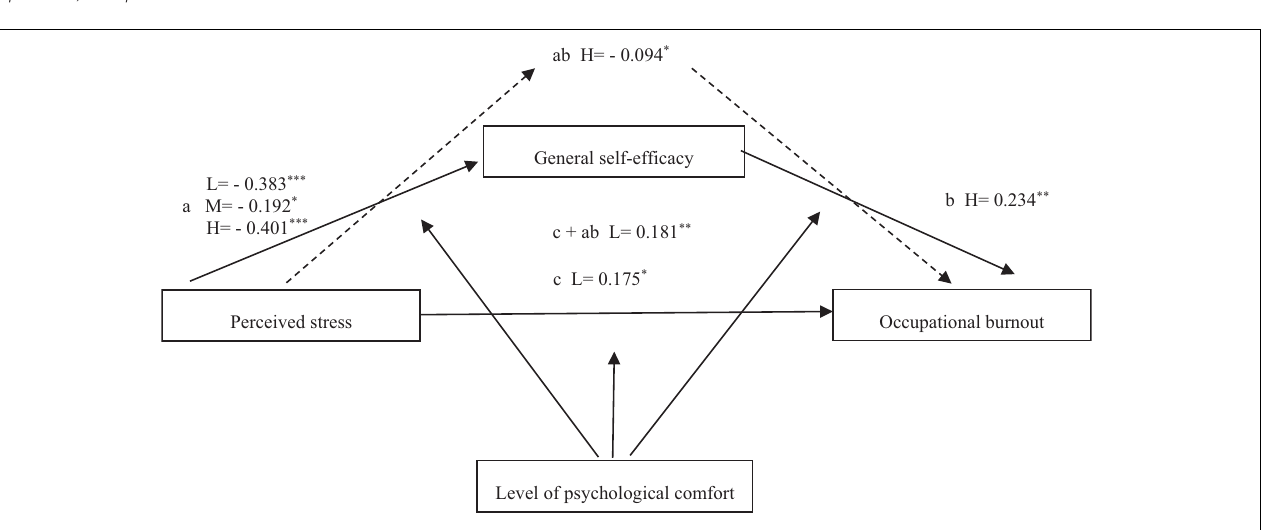
Frontiers in Psychology |